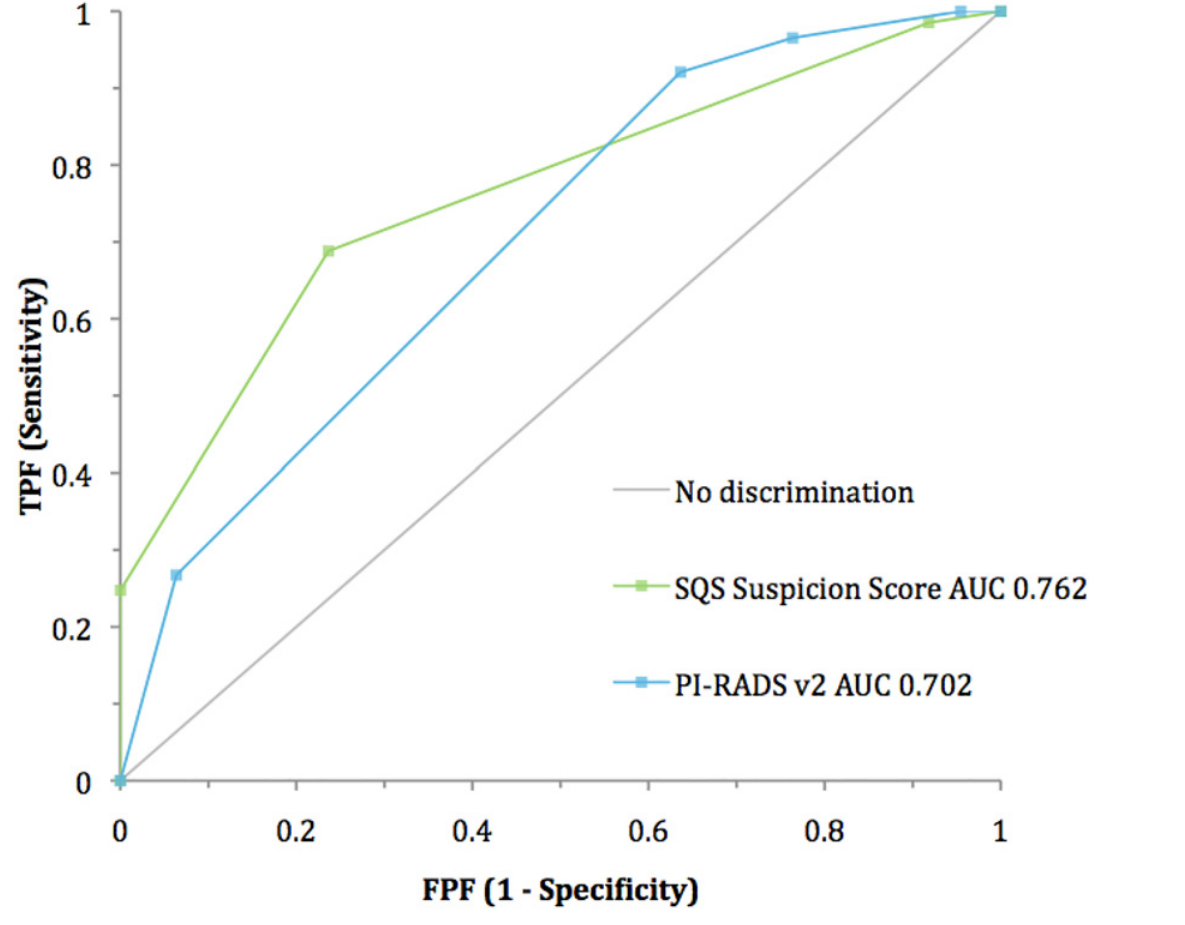
Fig 10. ROC curve analysis: